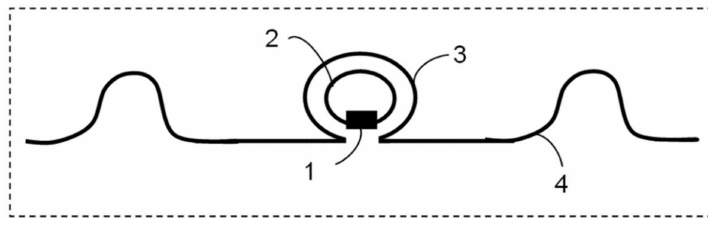
Figure 2. UHF RFID passive tag architecture with inductive